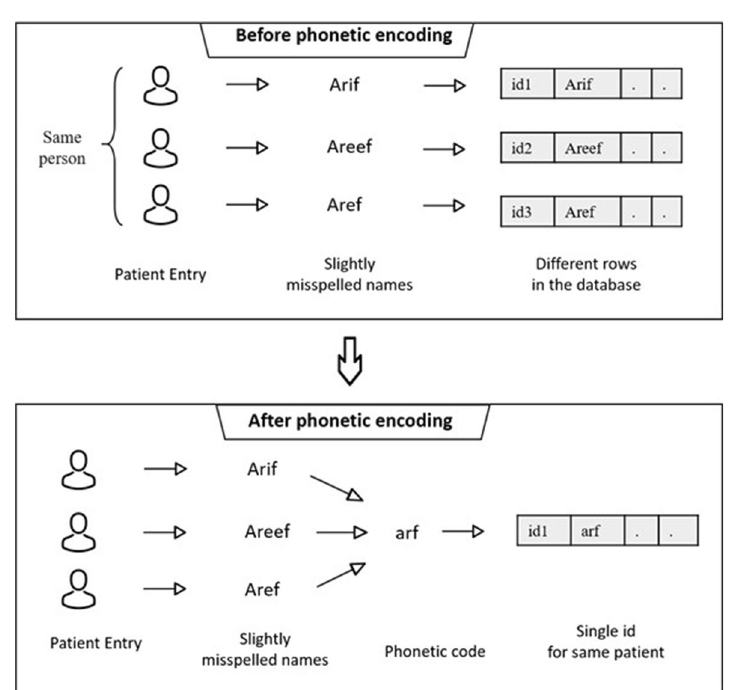
Fig. 7 Process of phonetic